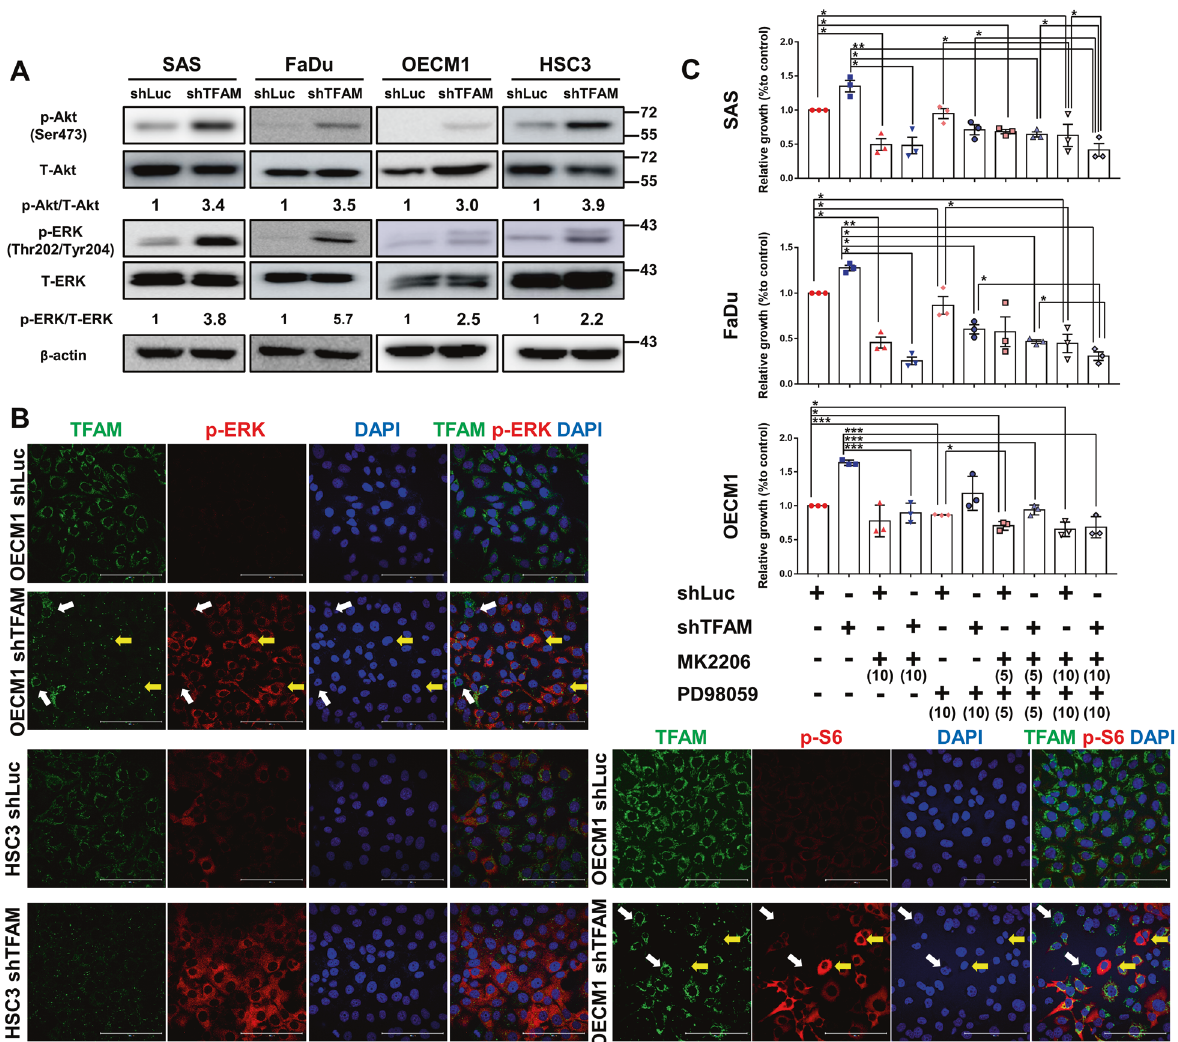
Fig. 4 PKB/Akt and ERK signalling pathways underlie TFAM mediated malignant changes in HNC cells. A Western blot analysis showed increased expression of phosphorylated Akt (Ser473), phosphorylated p44/42 MAPK ERK1/2 (p-ERK, Thr202/Tyr204) and mTORC pathway effector phosphorylated S6 Ribosomal Protein (p-S6, Ser235/Ser236) in TFAM-silenced HNC cells. B Immuno fl uorescence staining analysis indicated that HNC cells with lower TFAM expression (yellow arrows) exhibited greater phosphorylated S6 (p-S6) and phosphorylated ERK (p- ERK) expression as HNC cells with higher TFAM levels displayed less p-S6 and p-ERK (white arrows). Scale bar = 100 μ m. C Trypan blue exclusion assay for TFAM-silenced SAS, FaDu, OECM1 cells solely or co-treated with PKB/Akt inhibitor MK2206 and ERK1/2